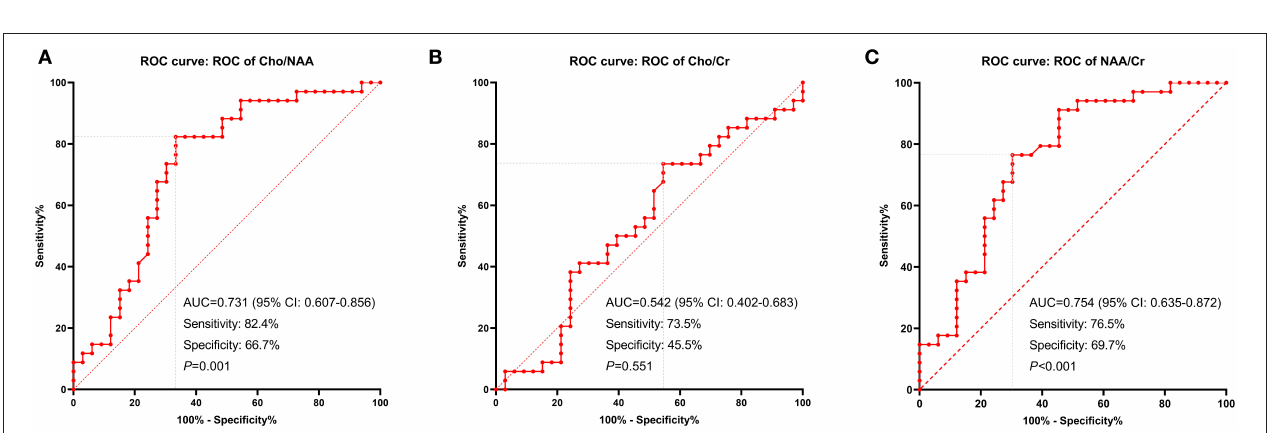
FIGURE 2 | Comparisons of metabolic ratios between target and reference regions by paired t -test. Comparing with reference region, ratios of Cho/NAA (0.57 ± 0.14 vs. 1.32 ± 0.59) and Cho/Cr (1.02 ± 0.27 vs. 1.36 ± 0.44) in the target region were remarkably increased, but the ratio of NAA/Cr (1.81 ± 0.48 vs. 1.20 ± 0.42) was significantly decreased ( P < 0.001). *** p < 0.001.